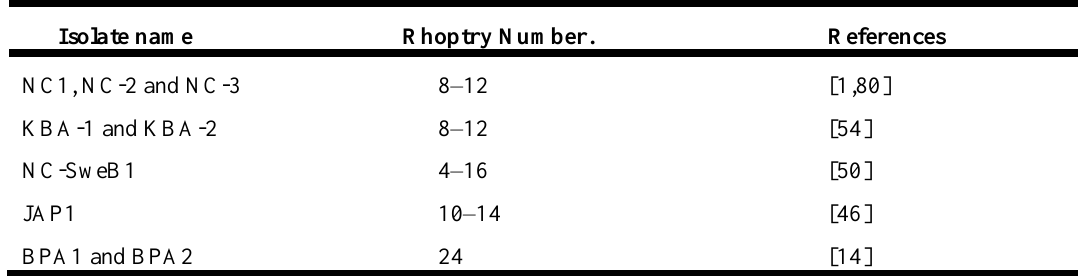
Table 3. Number of rhoptries present in different Neospora caninum tachyzoites. Isolate name Rhoptry